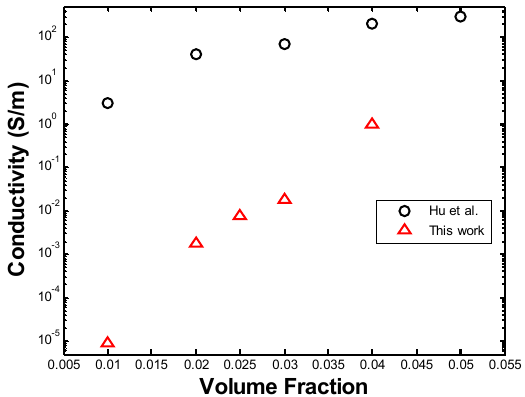
Figure 26. Comparison of PNC conductivity to the work by Hu et al. [12].